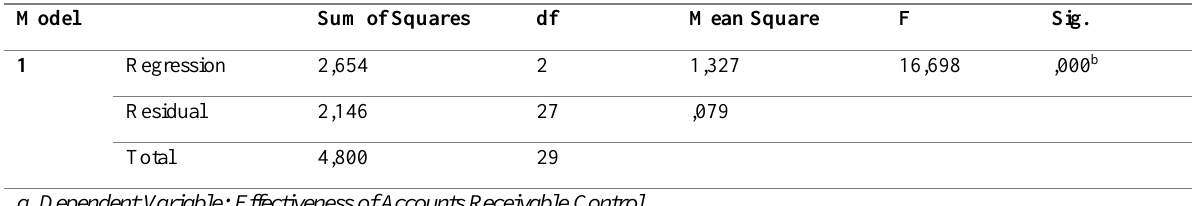
Table 2: Feasibility Test Results Model F ANOVA a